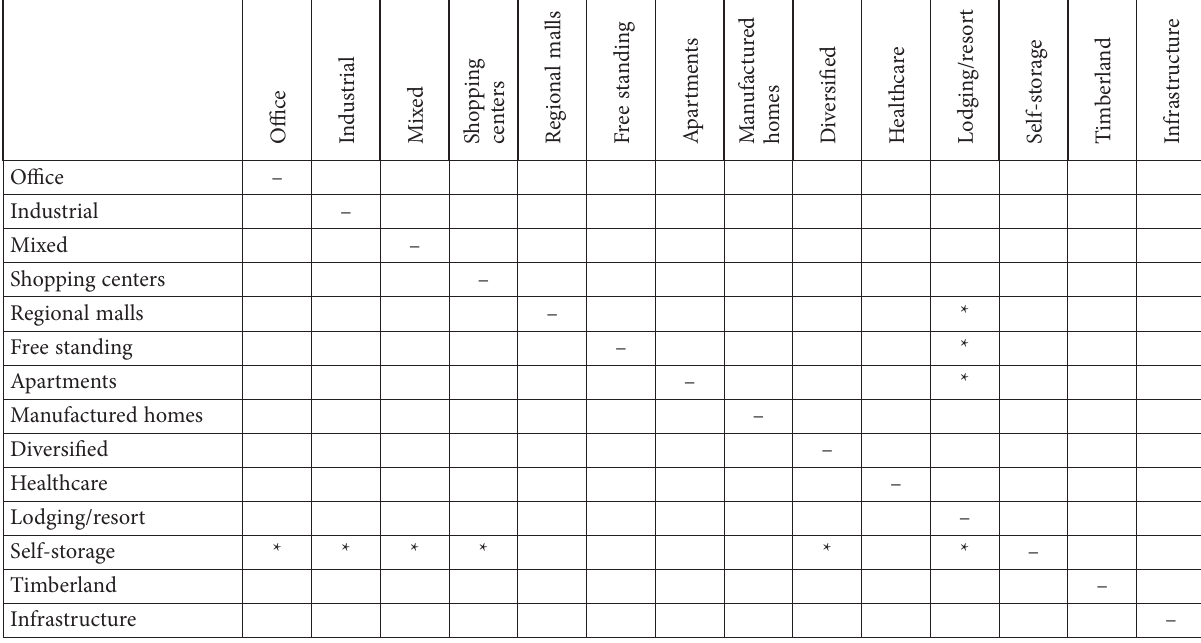
Table 8. Sharpe ratio comparison of different REIT subsectors (row versus column)